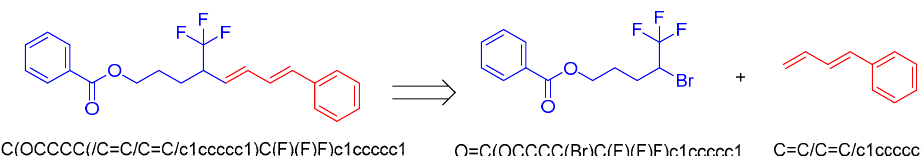
Figure 1. An example of a retrosynthetic prediction. The target module is shown to the left of the arrow and predicted reactants are displayed to the right. The SMILES code for each compound is also indicated.